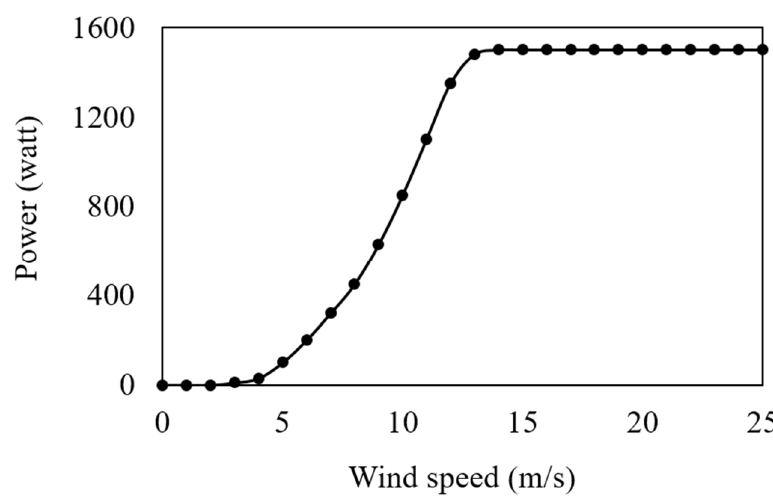
Figure 6. Power curve of wind turbine installed at experimental site [17].